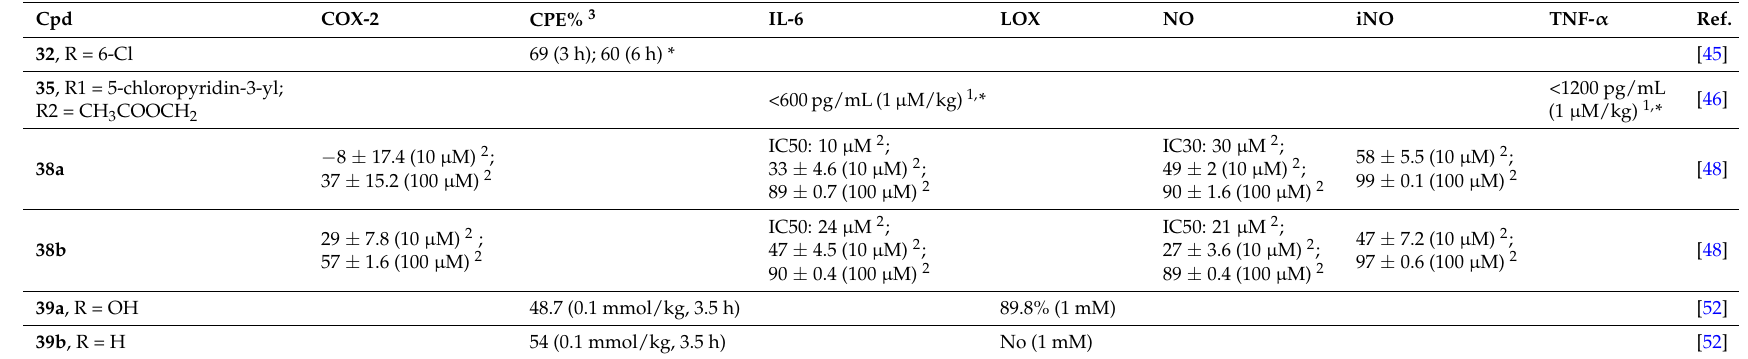
Table 4. Some anti-inflammatory activities of synthetic